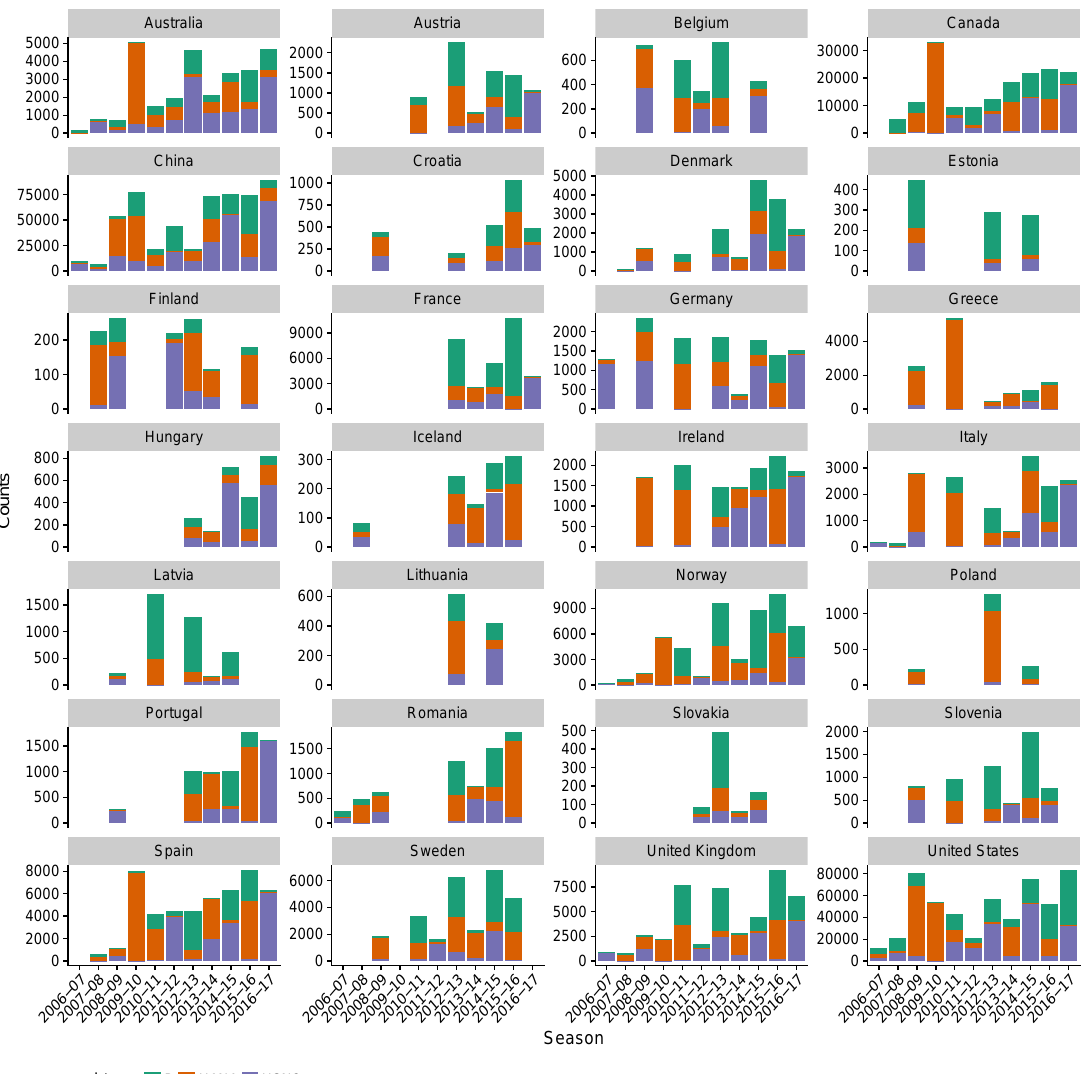
Figure A10. Seasonal counts of laboratory-tested respiratory samples identified by type and subtype, as reported in the WHO FluNet database are shown [52]. These data are used in the type and subtype-level analysis of vaccine-driven